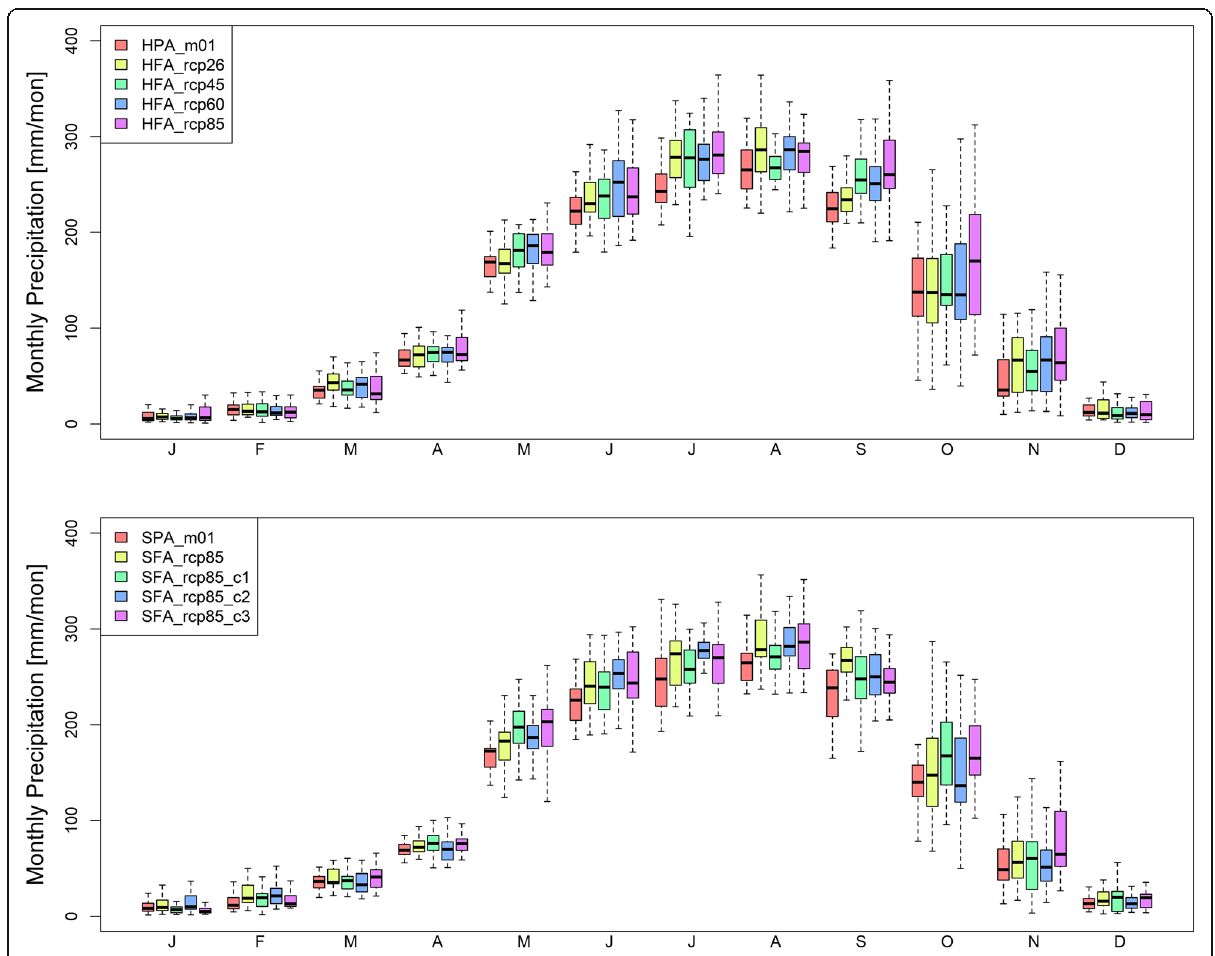
Fig. 5 Bias corrected monthly precipitation in present and future climate experiments of MRI-AGCM3.2H and MRI-AGCM3.2S models. The bottom and top of the box show first and third quartiles, and the flat line inside the box is median. The whiskers represent the minimum and maximum